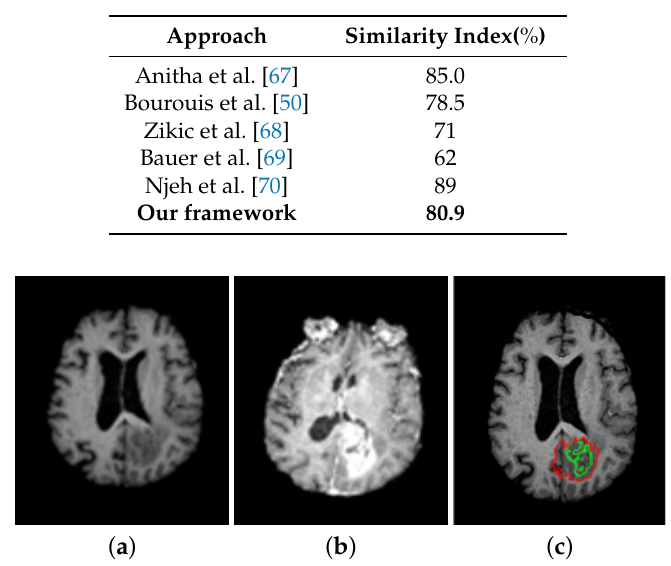
Table 5. Similarity index (%) for brain tumor detection using different approaches for the public dataset [65].